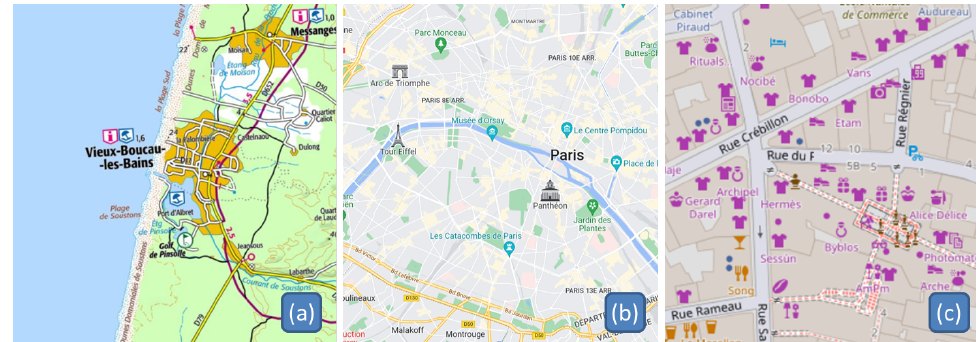
Figure 10. Three examples illustrating the pre-attentive mode of reconciliation. ( a ) The sea is a clear Gestalt element that enables a pre-attentive reconciliation (source: IGN). ( b ) Some touristic venues of Paris are highlighted with symbols that are very salient compared with the map background (source: Google Maps). ( c ) This cluttered map limits any pre-attentive reconciliation due to the amount of rendered information (source: OpenStreetMap